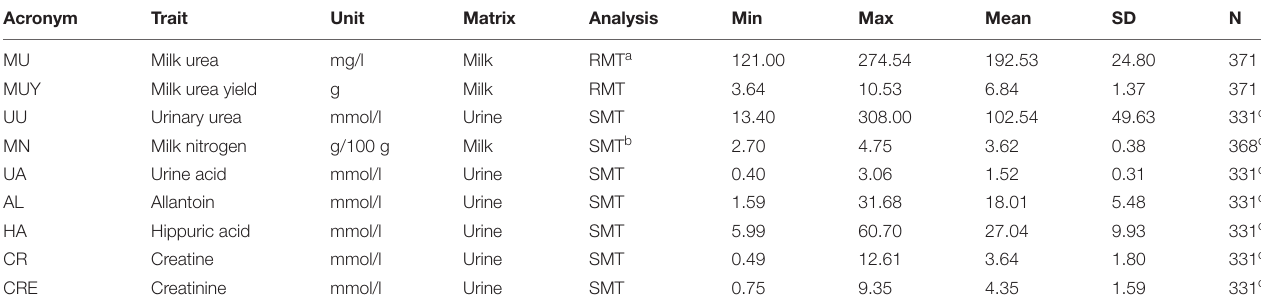
TABLE 1 | Descriptive statistics of milk and urinary nitrogen traits in Holstein